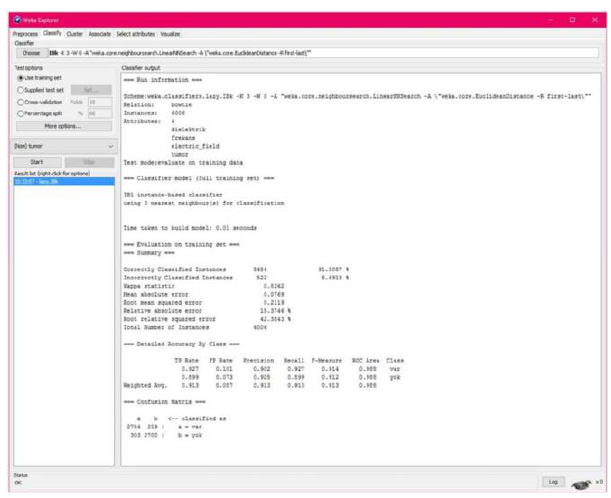
FIGURE 9. The result of IBK algorithm on WEKA tool The accuracy rate is calculated by total number of correct predictions divided by the total number of classifications and indicated in equation 5. The dataset is divided into k equal parts (K- fold cross validation). One-fold is used for testing and the rest k-1folds for training. This is repeated for k times